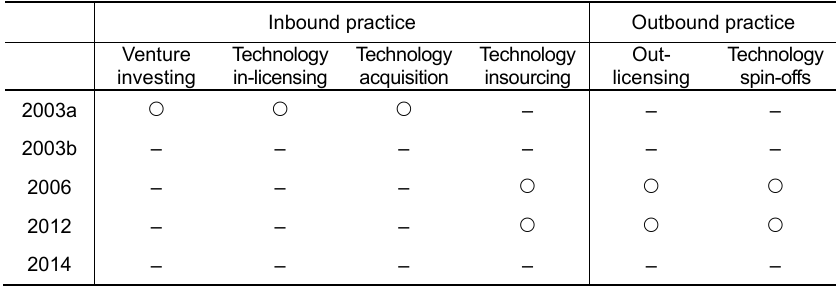
Table 1. OIP in Chesbrough’s books and